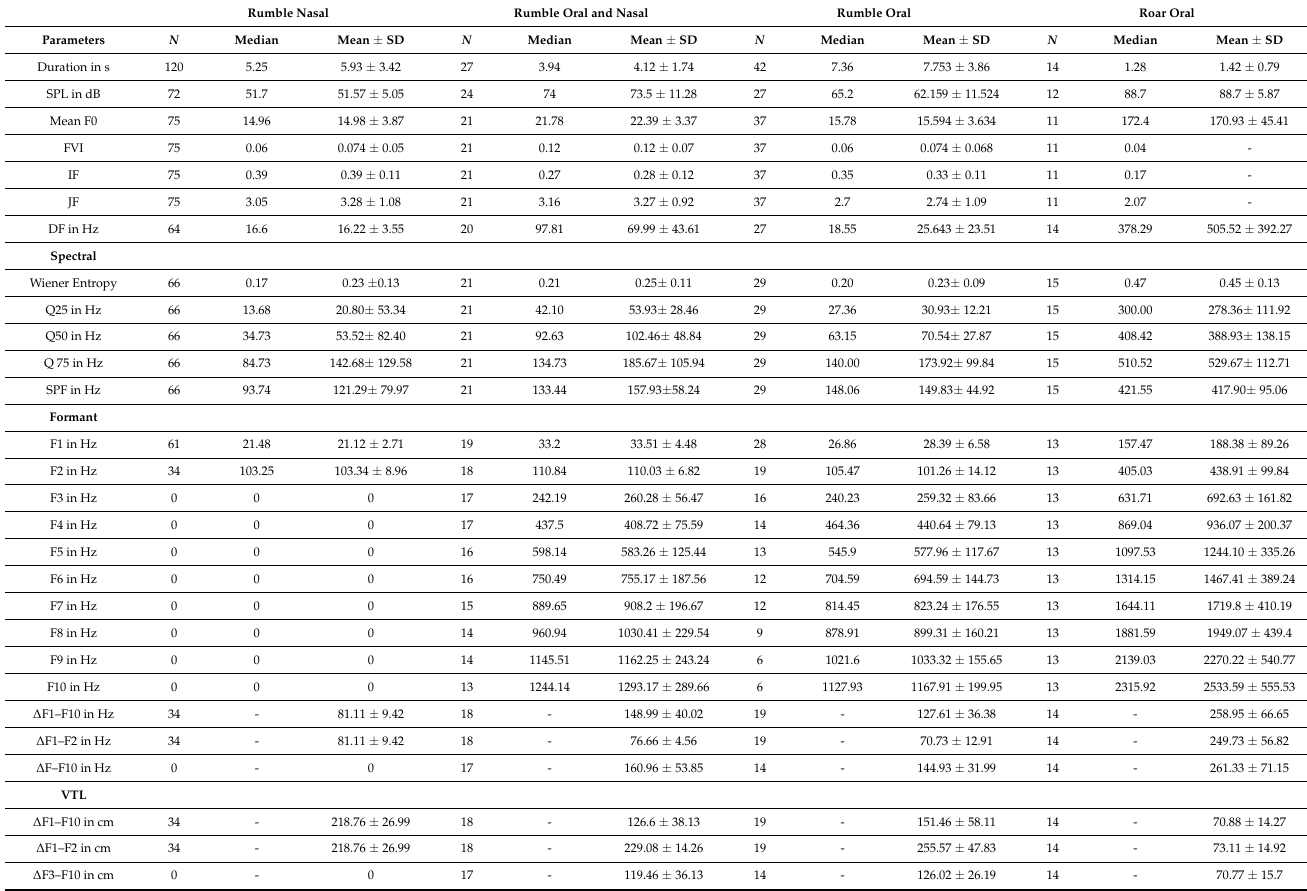
Table 5. Results of acoustic parameters measured per call emission type. The table shows sample sizes, median and mean values ±